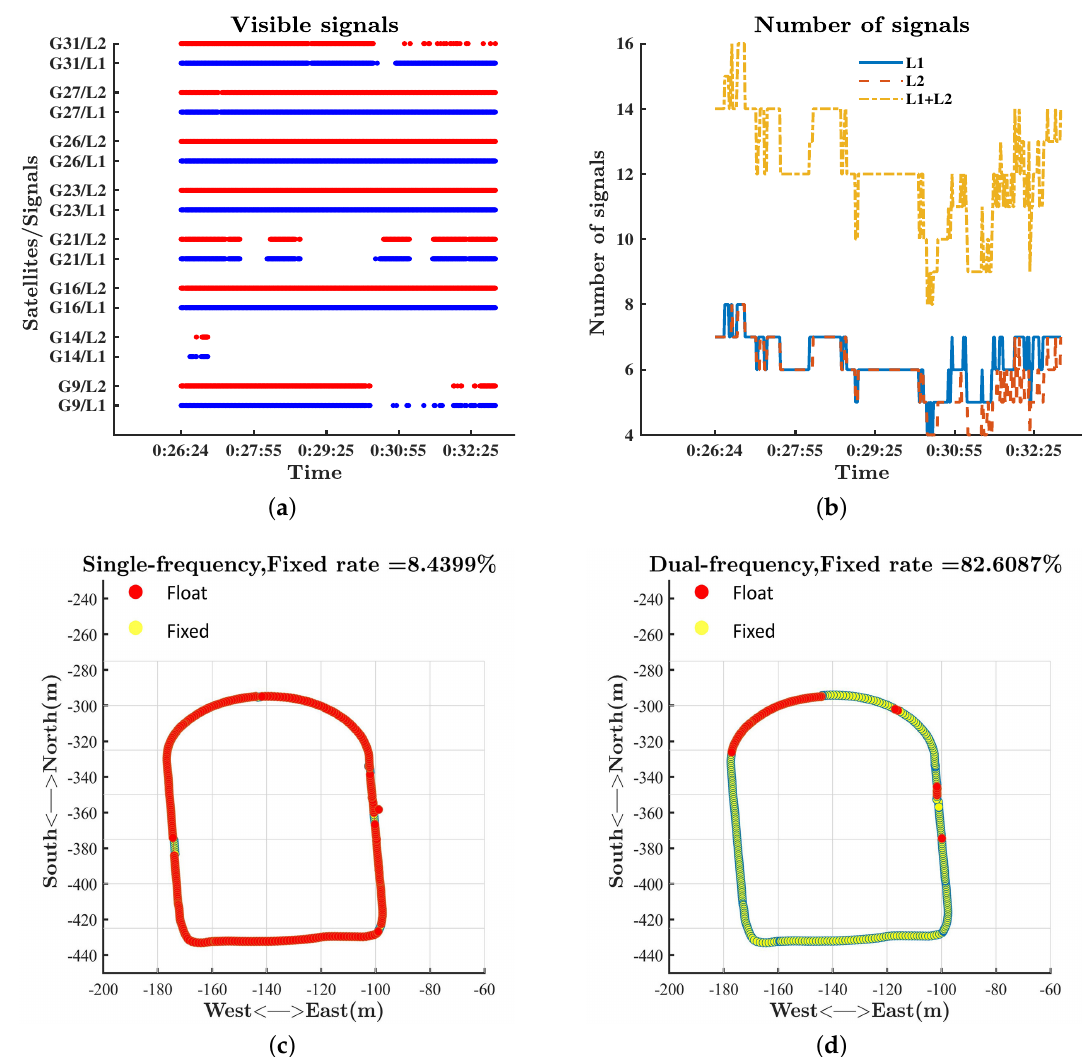
Figure 6. RTK performances based on the NovAtel receiver. ( a ) Visible signals and satellites; ( b ) number of different signals); ( c ) single-frequency RTK; ( d ) dual-frequency